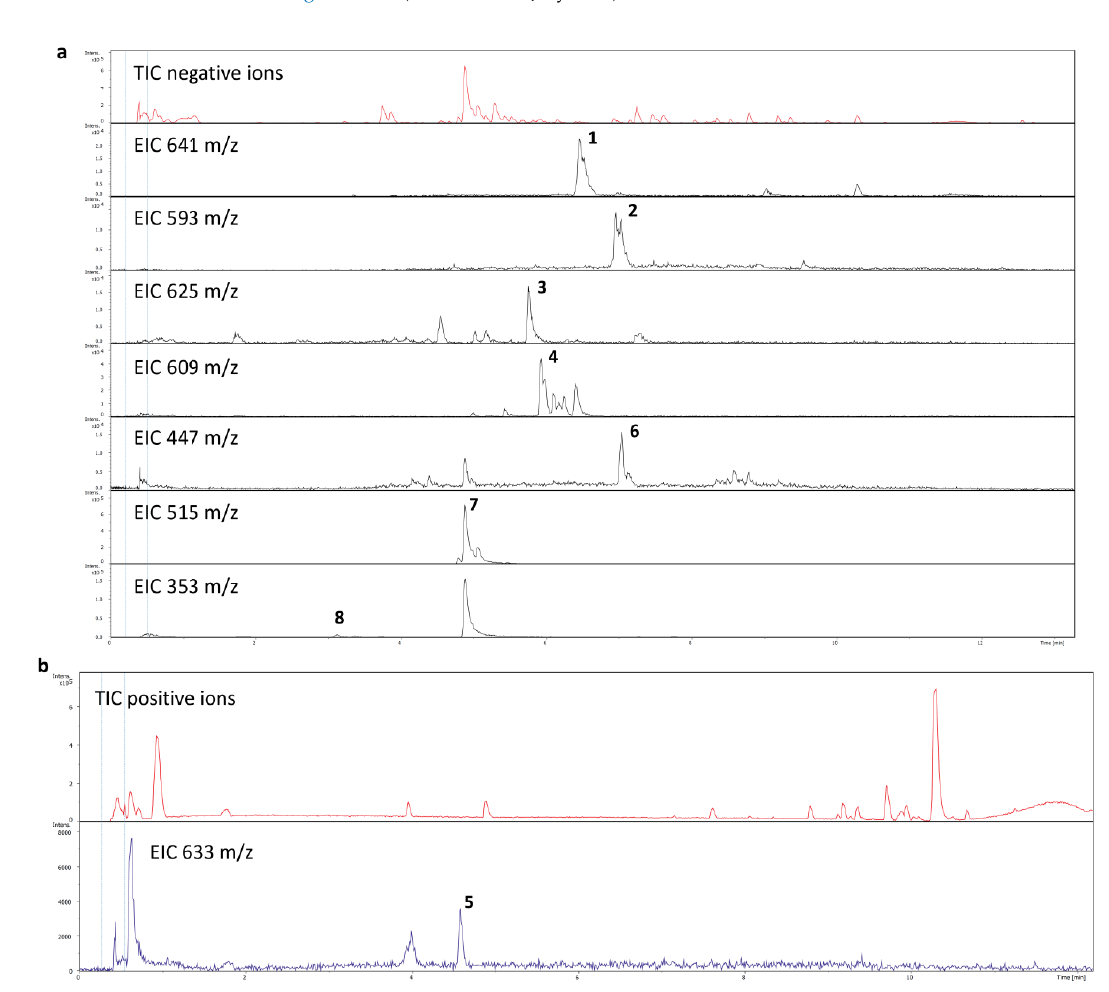
Figure 3. Total ion and extracted ion chromatograms of post culture medium registered in negative ( a ) and positive ( b ) MS mode.